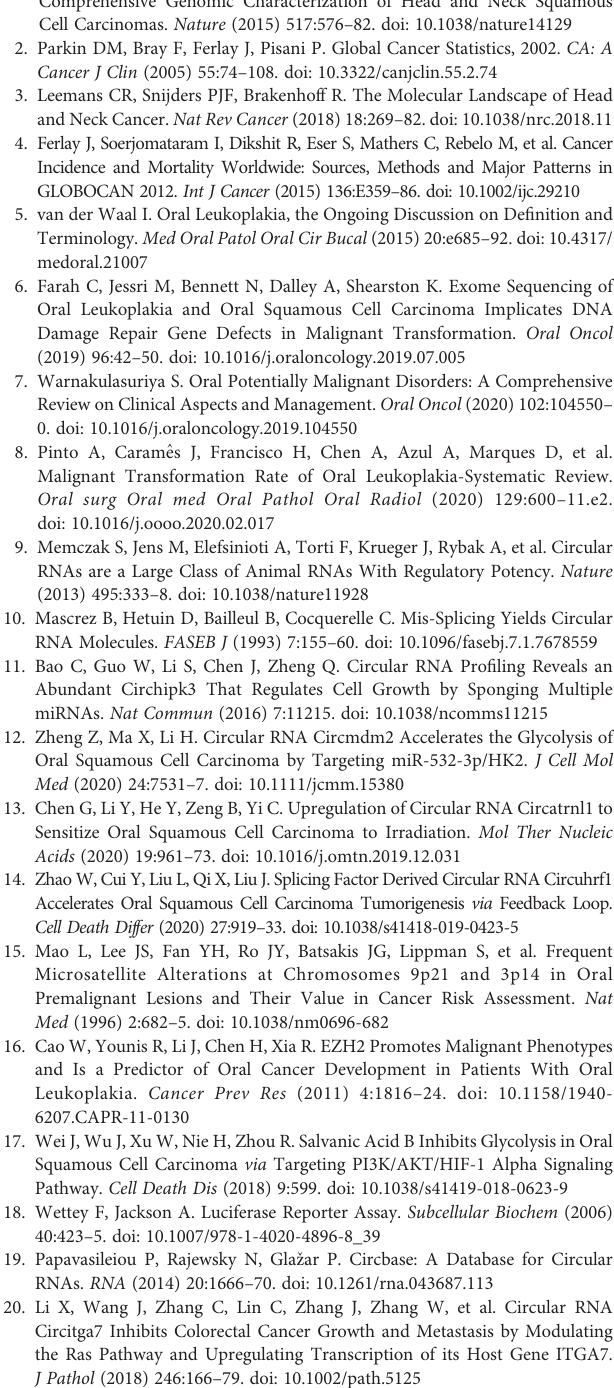
Supplementary Figure S2 | GO enrichment and KEGG pathway analysis. (A – C) Top 10 GO terms were exhibited in BP, CC and MF bubble diagram respectively. (D) Top ten KEGG pathway involved in differentially expressed